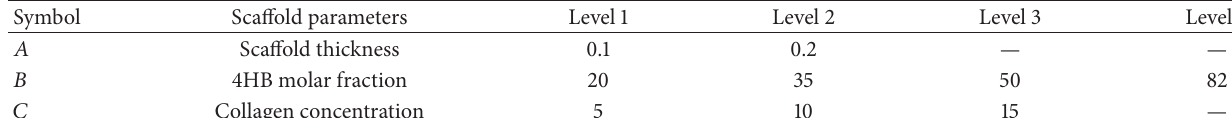
Table 3: The variables for P(3HB- co -4HB)/collagen blend fabrication using Taguchi method.